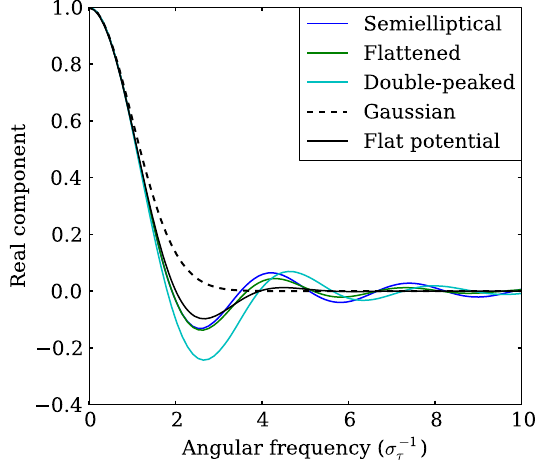
FIG. 7. Fourier transform of the beam signal around the first betatron tune line from tracking of beam distributions produced in time domain simulations of coupled-bunch instabilities at a chromaticity of 2.4. The frequency axis is given in terms of the revolution frequency f 0